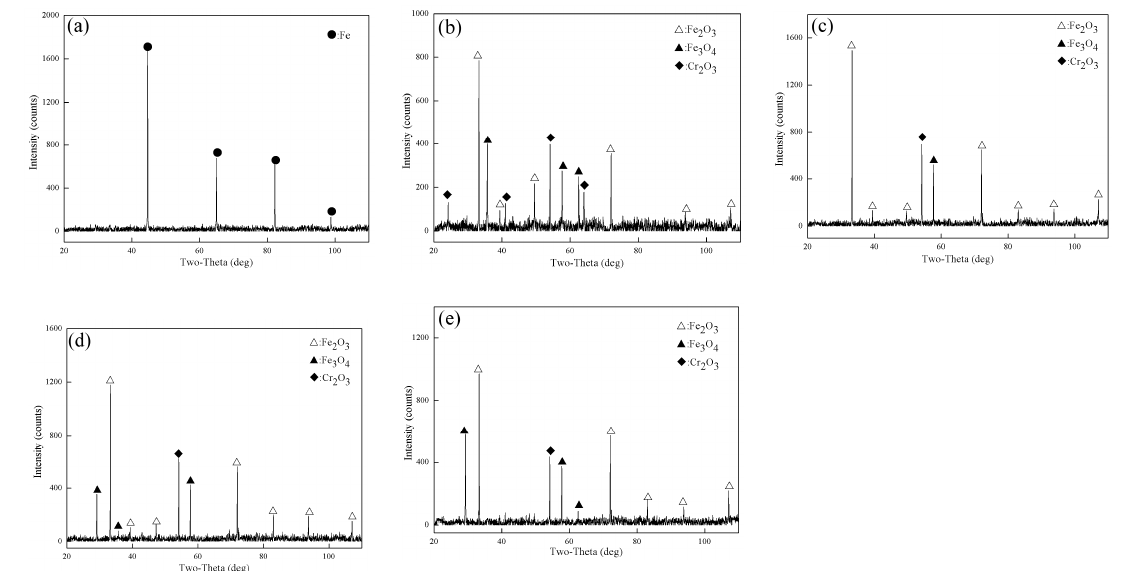
Figure 2. XRD patterns of Fe–10Cr steel in air atmosphere. ( a ) 800 °C ; ( b ) 900 °C ; ( c ) 1000 °C ; ( d ) 1100 °C ; ( e ) 1200 °C .